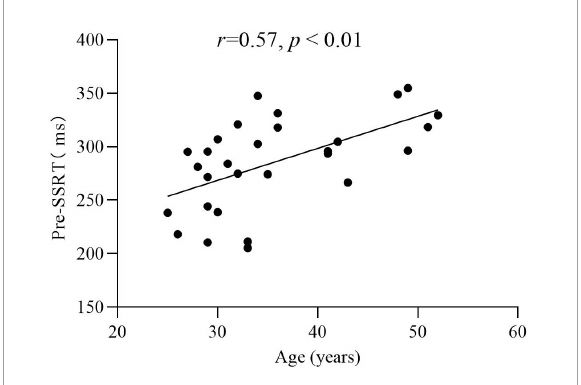
FIGURE3 Correlation analysis of the pre-SSRT and age in the experimental group ( r = 0.57, p < 0.01).